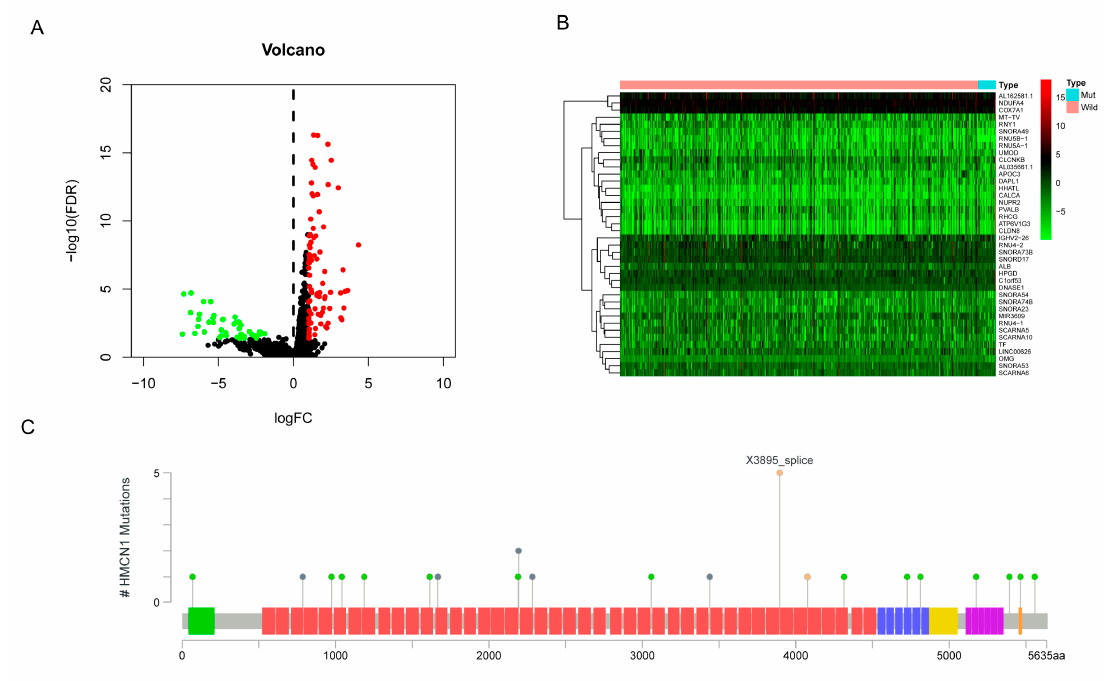
Figure 6. Differentially expressed genes analysis. ( A ) Volcano map of DEGs. Red: significantly up-regulated genes; Green: significantly down-regulated genes. ( B ) Heatmap of DEGs. ( C ) HMCN1 mutation types and sites in KIRC. Green: von Willebrand factor type A domain; Red: Immunoglobulin I-set domain; Blue: Thrombospondin type 1 domain; Yellow: G2F domain; Purple: Calcium-binding EGF domain; Orange: Complement Clr-like EGF-like.